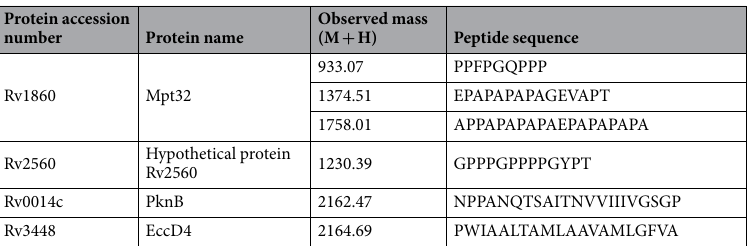
Table 3. Peptides identified from MALDI-TOF analysis of fraction 9–7 of pronase digested WCL from the X4-19 Δ HspX Mtb